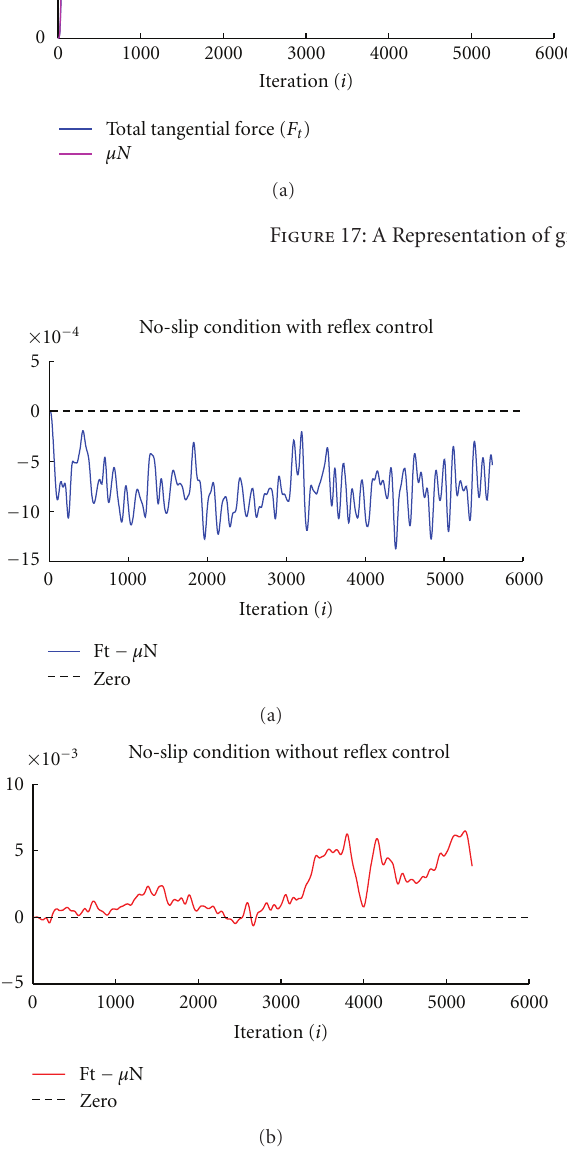
Figure 18: Plots of No-Slip condition in the two simulation tests.